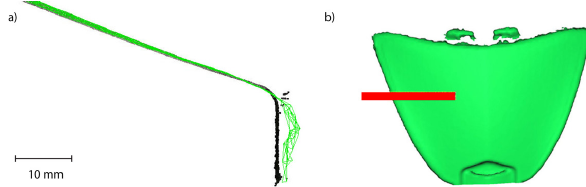
Figure 8: A close-up of a cross section (a) of a marked position (b), showing the photogrammetric point cloud (in black) overlaid with the Structure Sensor mesh (in green).